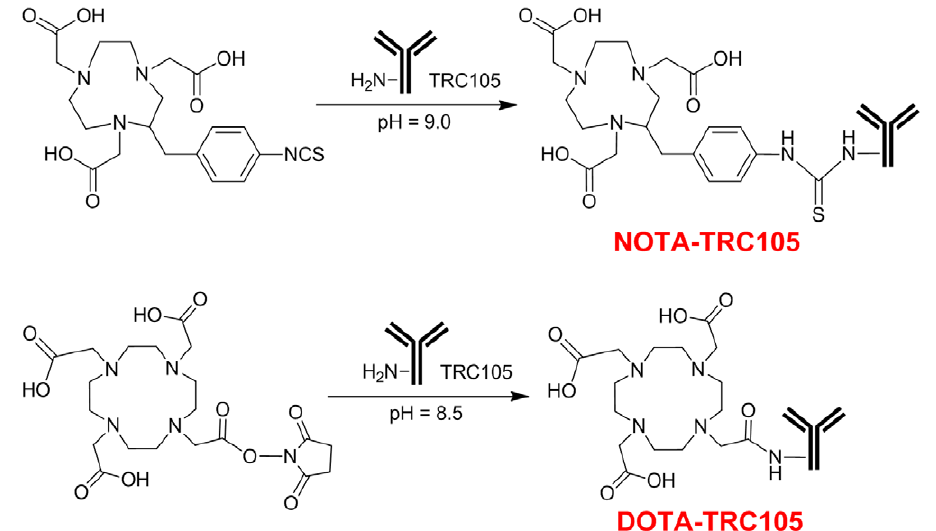
Figure 1. NOTA and DOTA conjugation of TRC105.